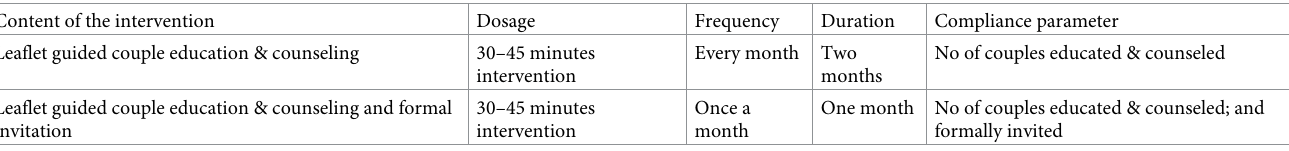
Table 1. Summary of the intervention